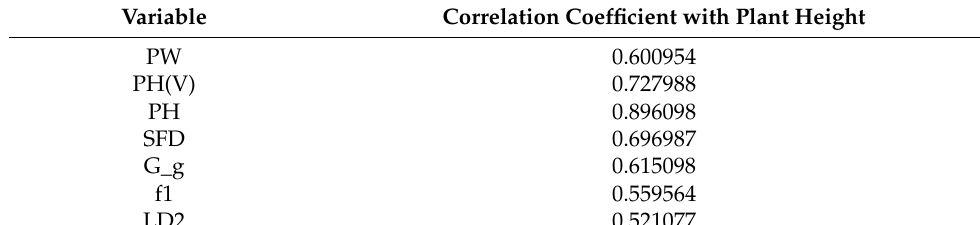
Table 4. Correlation coefficient between rice characterization and plant height.